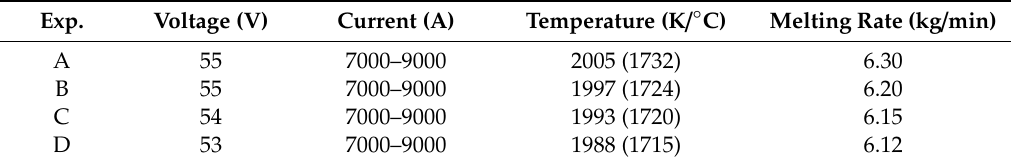
Table 1. The related refining parameters of the four experiments.